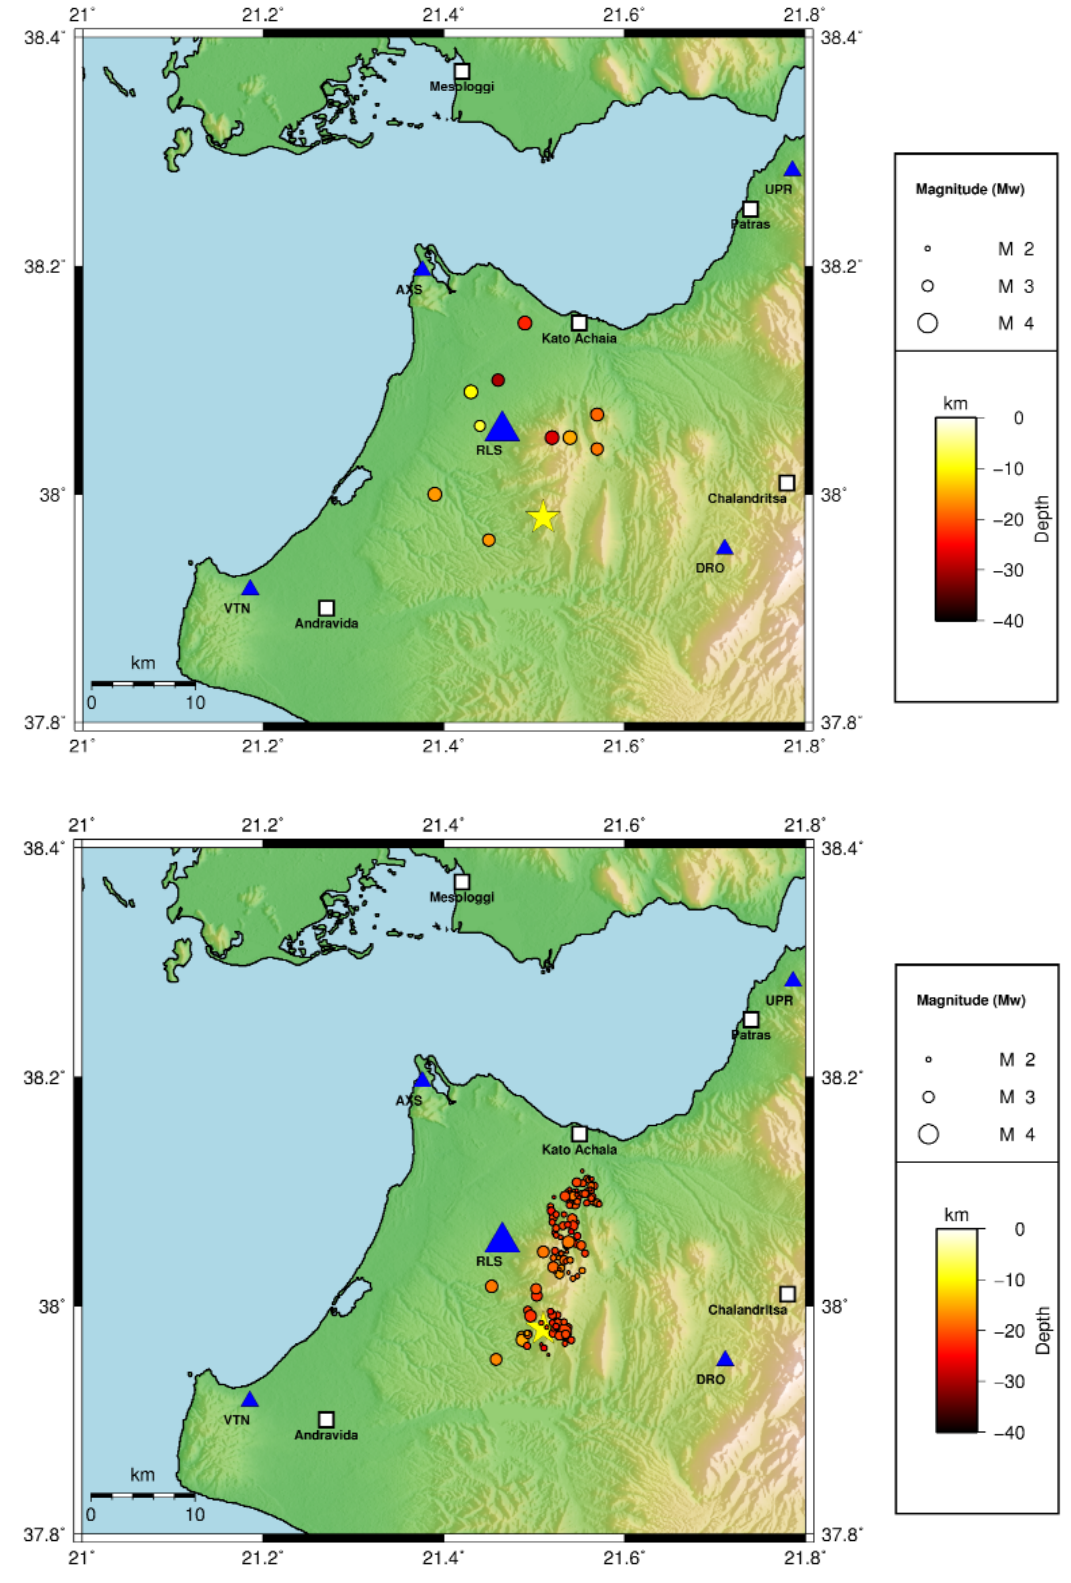
Figure 3 (top). Map of northwestern Peloponnese, showing the events from which the valid splitting results were obtained for the period before the Movri Mountain earthquake. The RLS station (large triangle), some of the HUSN seismic stations (small triangles), the Movri Mountain earthquake epicenter (star), and the major cities (squares) are shown. The colored circles represent epicenters. The depths of the events are color coded according to the color scale (right). The diameters of the circles are proportional to the magnitudes. Figure 4 (bottom). Map of northwestern Peloponnesus, showing the events from which the valid splitting results were obtained for the period after the Movri Mountain earthquake. The RLS station (triangle), some of the HUSN seismic stations (small triangles), the Movri Mountain earthquake epicenter (star), and the major cities (squares) are shown. The colored circles represent epicenters. The depths of the events are color coded according to the color scale (right). The diameters of the circles are proportional to the